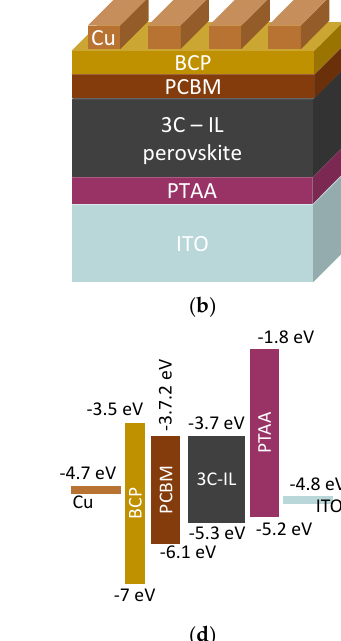
Table 1, the SnO (cid:2908) architecture is characterized by a larger short ‐ circuit current 𝐽 (cid:3020)(cid:3004) , likely due to the large electron mobility of SnO (cid:2908) (in the order of 10 to 100 cm 2 V ‐ 1 s ‐ 1 [23,24]; com ‐ pared to 10 ‐ 2 cm 2 V ‐ 1 s ‐ 1 [25] of PCBM and to 10 ‐ 7 cm 2 V ‐ 1 s ‐ 1 of BCP [26]) that promotes an